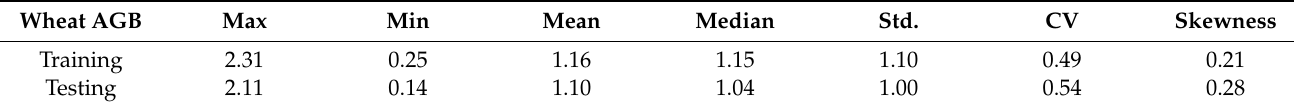
Table 3. AGB statistical characteristics during training and testing